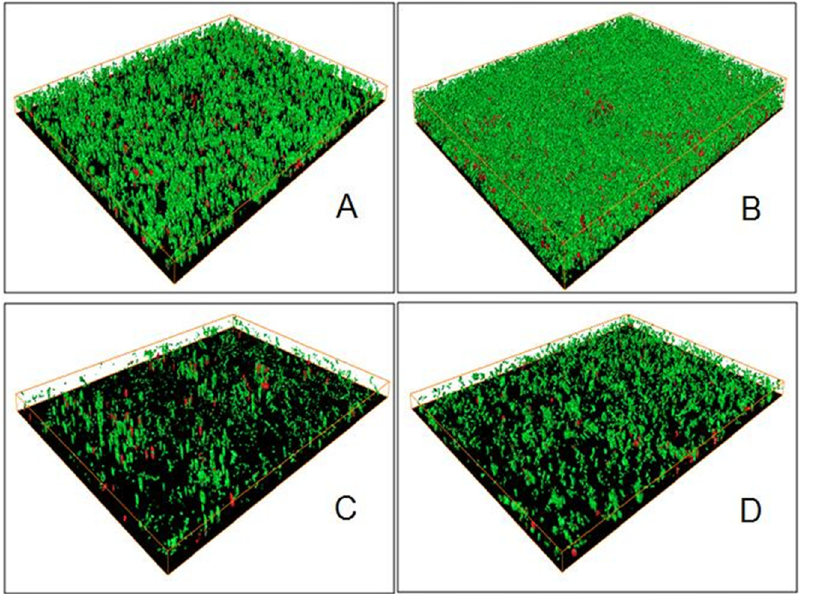
Figiure 1. Confocal laser scanning micrographs of biofilms developed by E.coli K-12 in 10% LB broth with different reagents. A, control, without any additional reagents; B, with 400 m M of dATP;, C, with 40 U/ml of DNase I; and D, with 200 mU/ml of Apyrase. Biofilms were examined after 16 hrs incubation after inoculation at 30 u C in a 96-well microtiter plate. Bacterial cells were stained with Bacterial LIVE/DEAD staining dyes and viable cells shown green and dead or membrane damaged cells shown red in the images.